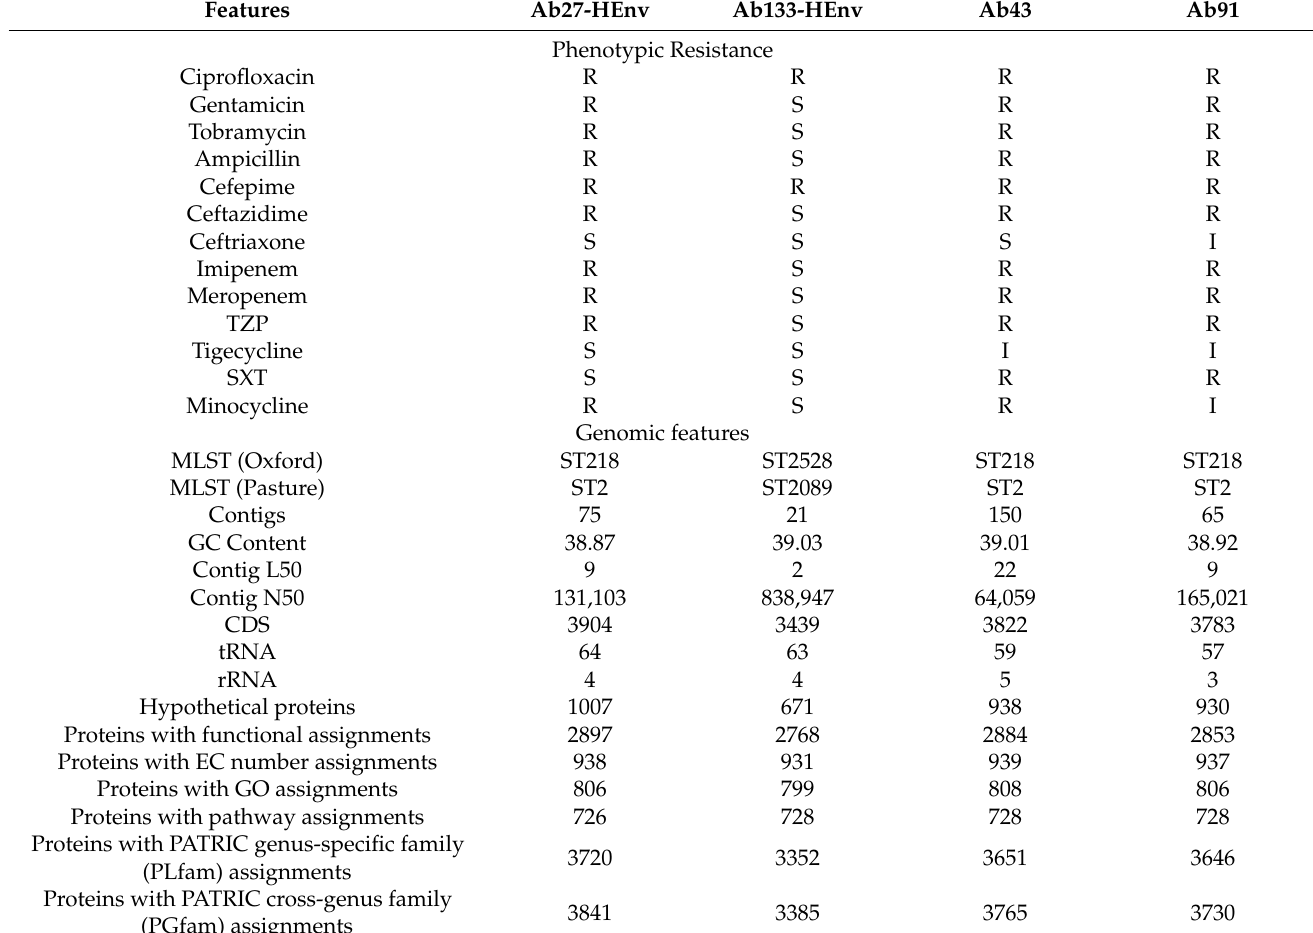
Table 1. Antimicrobial susceptibility and genomic annotation of the Acinetobacter baumannii